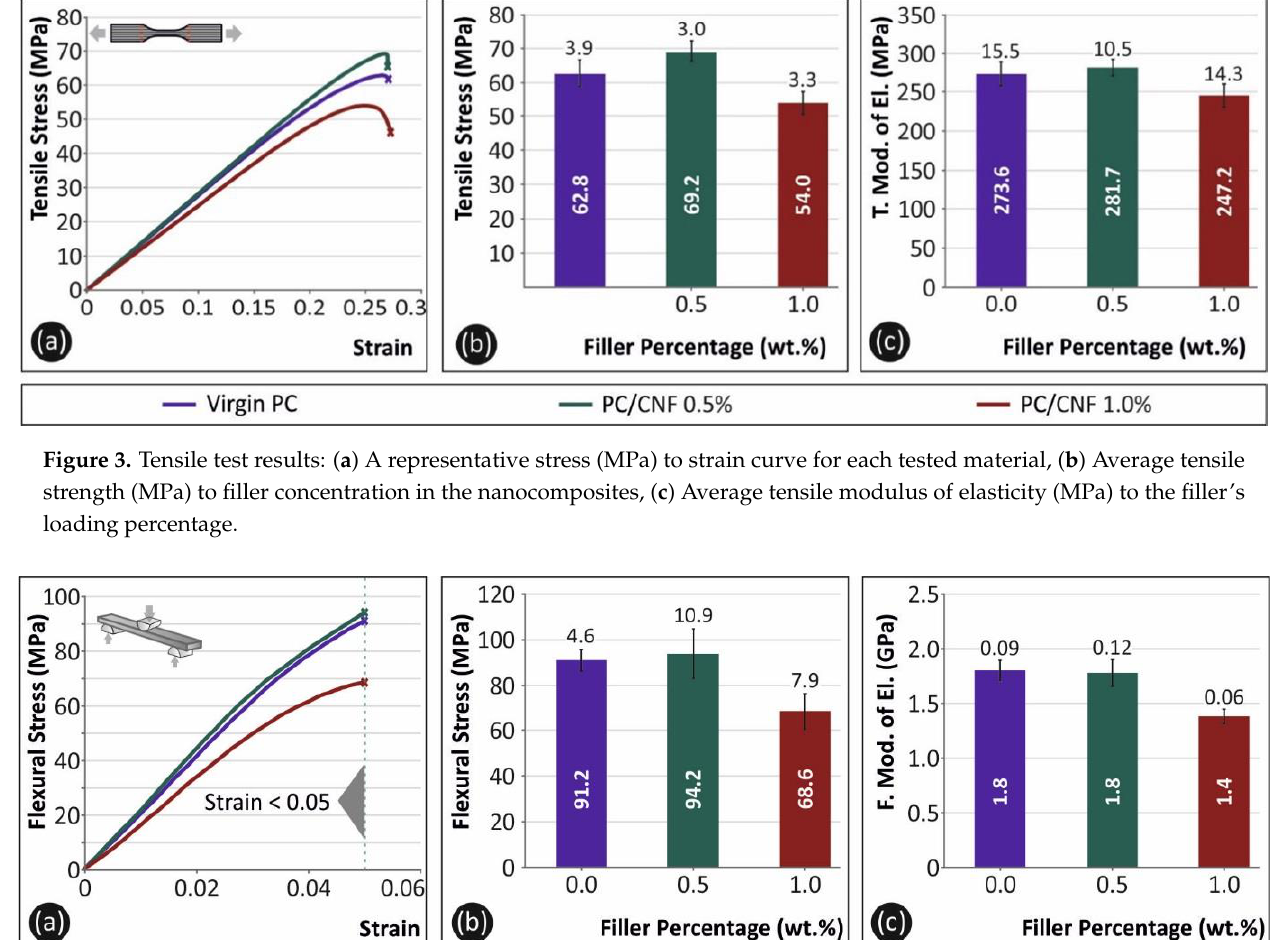
Figure 3. Tensile test results: ( a ) A representative stress (MPa) to strain curve for each tested material, ( b ) Average tensile strength (MPa) to filler concentration in the nanocomposites, ( c ) Average tensile modulus of elasticity (MPa) to the filler’s loading percentage.